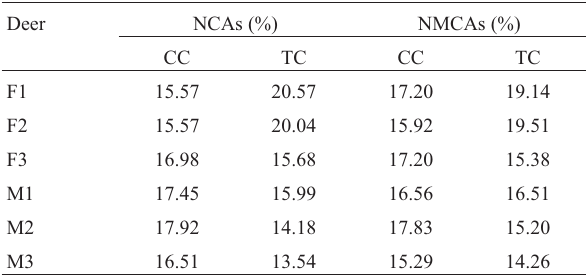
Table 1 - Percentage of the number of chromosomal aberrations (NCAs) and the number of metaphases carrying chromosomal aberrations (NMCAs) in control cell cultures (CC) and doxorubicin-treated cell cul- tures (TC). Female (F1, F2 and F3), male (M1, M2 and M3).